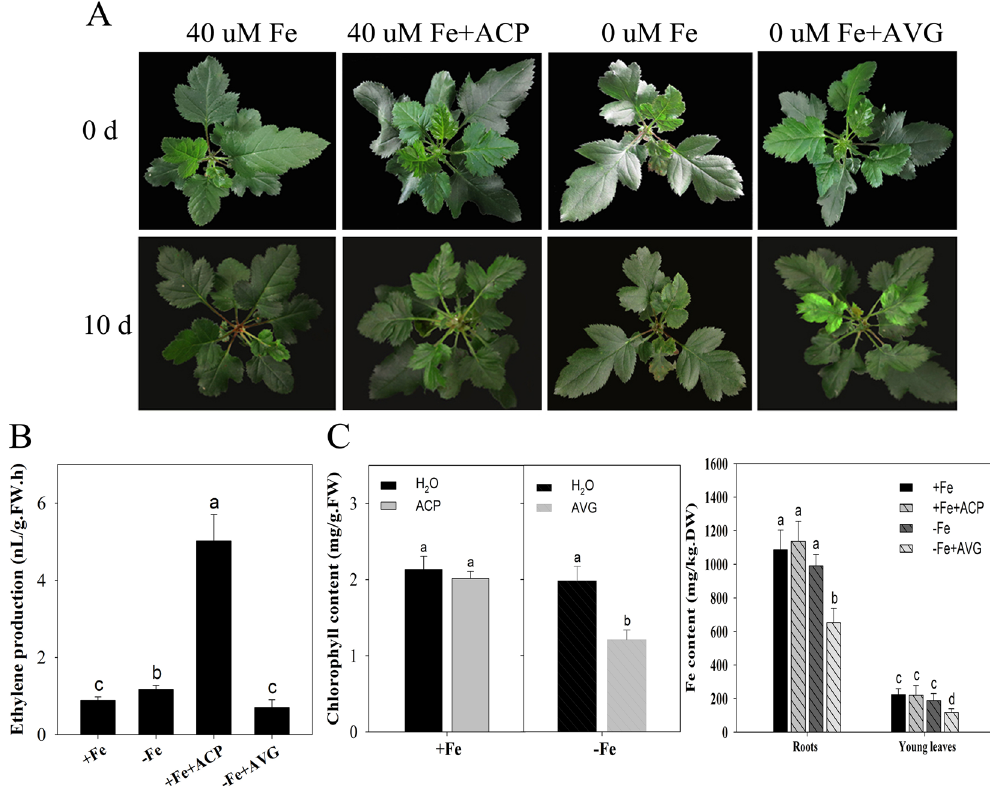
Figure 1. Effect of ethylene on the phenotype of Fe-deficient Malus xiaojinensis . ( A ) The phenotype of M . xiaojinensis seedlings grown in media supplied with 40 µ M Fe, 40 µ M Fe + 100 mg/L 2-Chloroethylphosphonic acid (ACP), 0 µ M Fe, 0 uM Fe + 10 µ M aminoethoxyvinylglycine (AVG) for 10 d respectively. ( B ) The ethylene production of M. xiaojinensis seedlings grown in media supplied with 40 µ M Fe, 40 µ M Fe + 100 mg/L ACP, 0 µ M Fe, 0 µ M Fe + 10 µ M AVG for 2 d. Bars represent means ± SE of three replicates. Different letters represent statistically different means at P < 0.05 (one-way ANOVA analysis with Duncan post-hoc test). (C) The chlorophyll content and Fe content of M. xiaojinensis seedlings grown in media supplied with 40 µ M Fe, 40 µ M Fe + 100 mg/L ACP, 0 µ M Fe, 0 µ M Fe + 10 µ M AVG for 2 d. Bars represent means ± SE of of three replicates. Different letters represent statistically different means at P < 0.05 (one-way ANOVA analysis with Duncan post- hoc